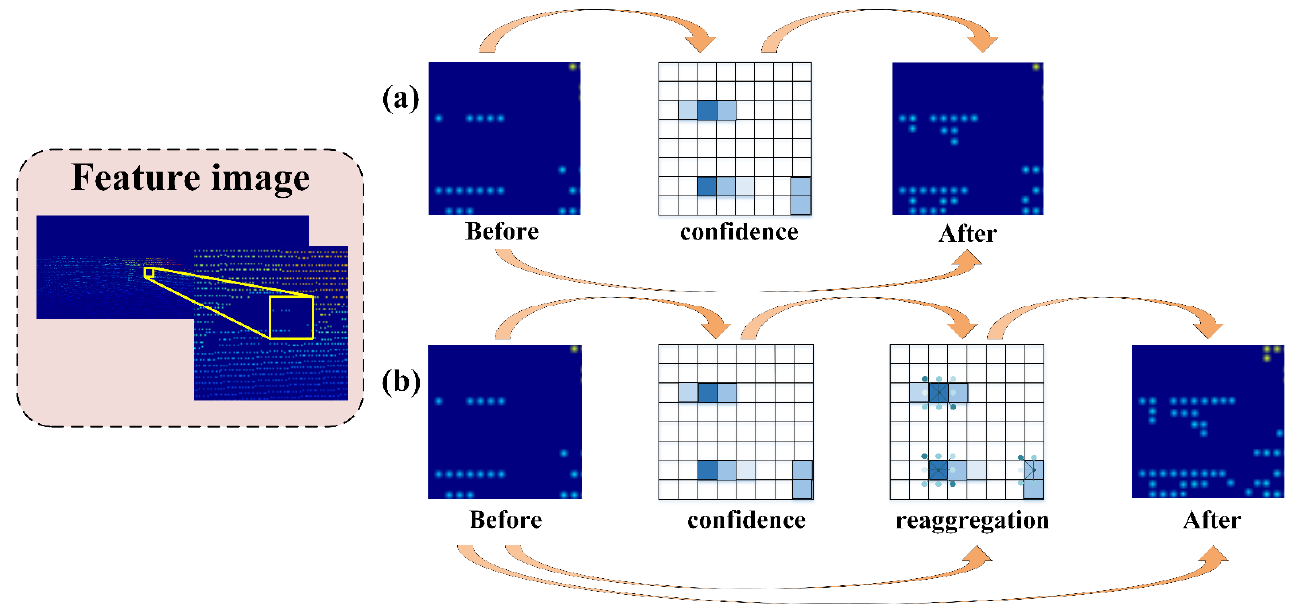
Figure 2. The structure of the confidence re-aggregation module. We selected a square window in a feature image as an example to show it. ( a ) is the processing method of ordinary confidence. The confidence is obtained from the input. And then the input goes with the confidence to get the output. ( b ) is our processing method for confidence re-aggregation. We added a step in the middle. The confidence is re-aggregated based on the input.